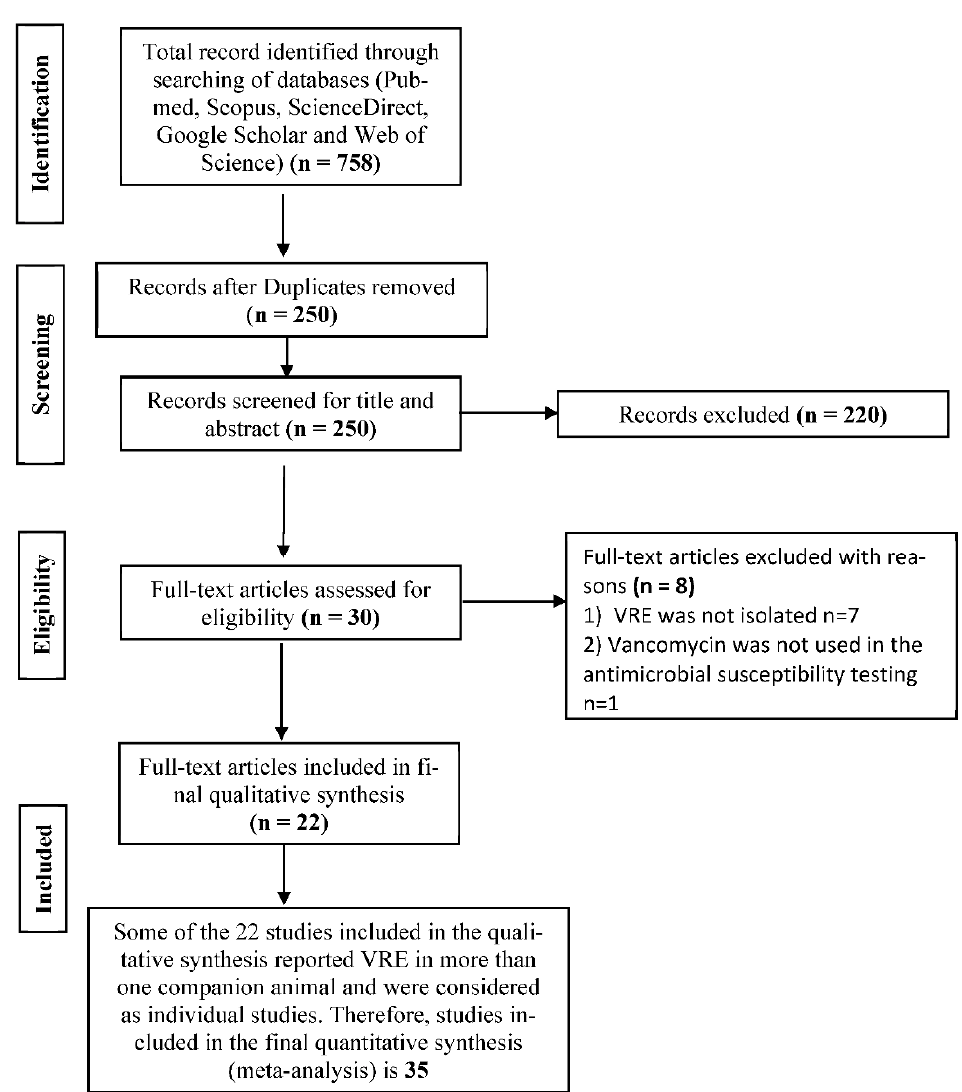
Figure 1. PRISMA flow diagram for the selection of eligible articles included in the study. The global distribution of VRE showing country prevalence rates and number of studies reporting VRE is shown in Figure